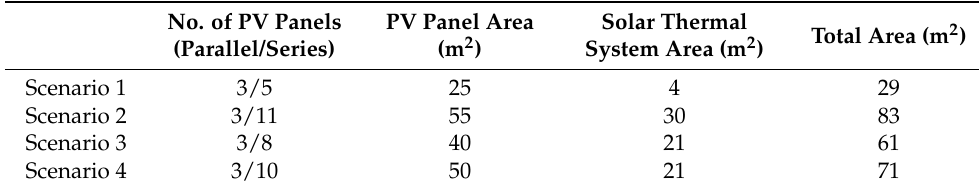
Table 9. The total area in m 2 for each simulation scenario according to the number of PV-panels used and the solar-thermal system